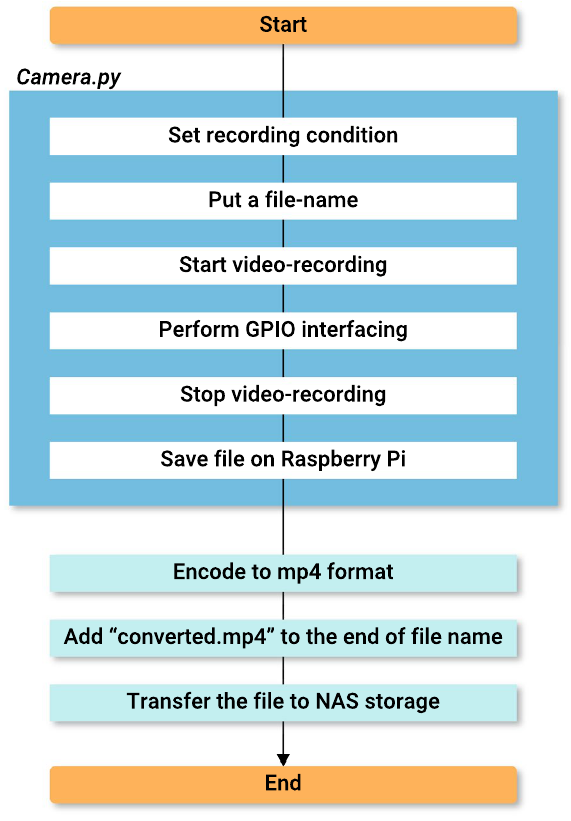
Figure 2. Flowchart of Record.sh . Running Record.sh , Python script Camera.py is run. It executes video- recording, file-naming and GPIO interfacing with the setting in itself. After running Camera.py , recorded file